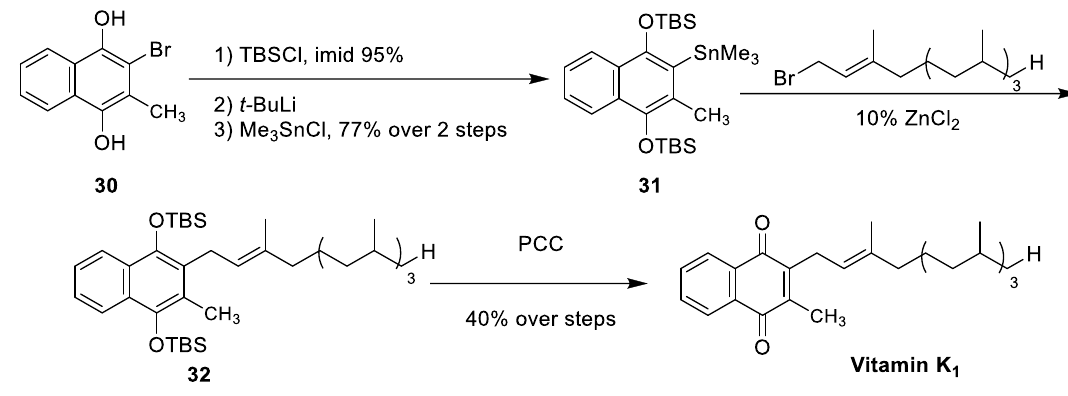
Scheme 14. Synthesis of vitamin K 1 using Stille organostannane chemistry [70].